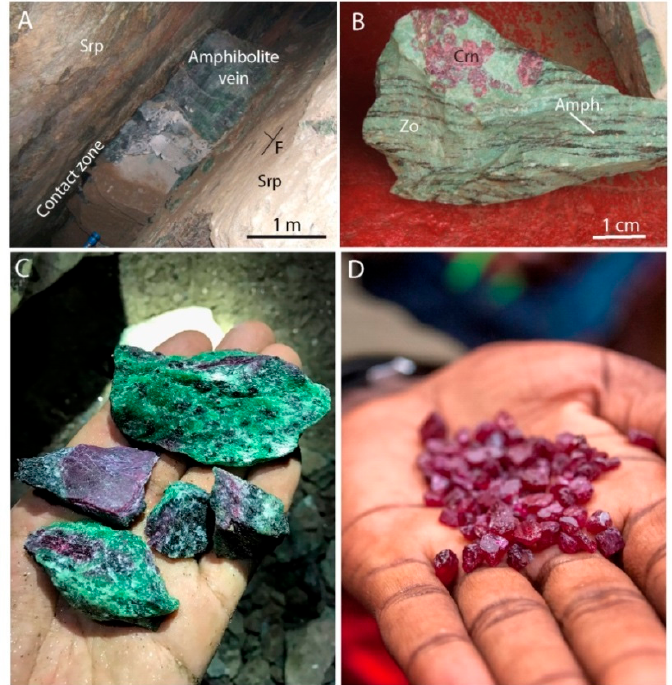
Figure 30. The ruby-bearing amphibolite from Longido, Northern Tanzania. ( A ) The amphibolite dyke, which is up to 1 m thick and parallel to the metamorphic foliation, crosscuts a serpentinite. The contact zone between the two rocks is marked by the presence of a phlogopite and amphibole-bearing schist. Photo: Elisabeth Le Goff; ( B ) anyolite with patches of ruby (Crn) and retrograde zoisite (Zo). Remnants of the amphibolite (Amph) highlight the metamorphic foliation. Photo: Elisabeth Le Goff; ( C ) representative samples of anyolite with ruby and black amphibole (tschermakite). Photo: Vincent Pardieu; ( D) ruby crystals extracted from new veins that are very different to the classical massive ruby of Longido. Photo: Vincent Pardieu.